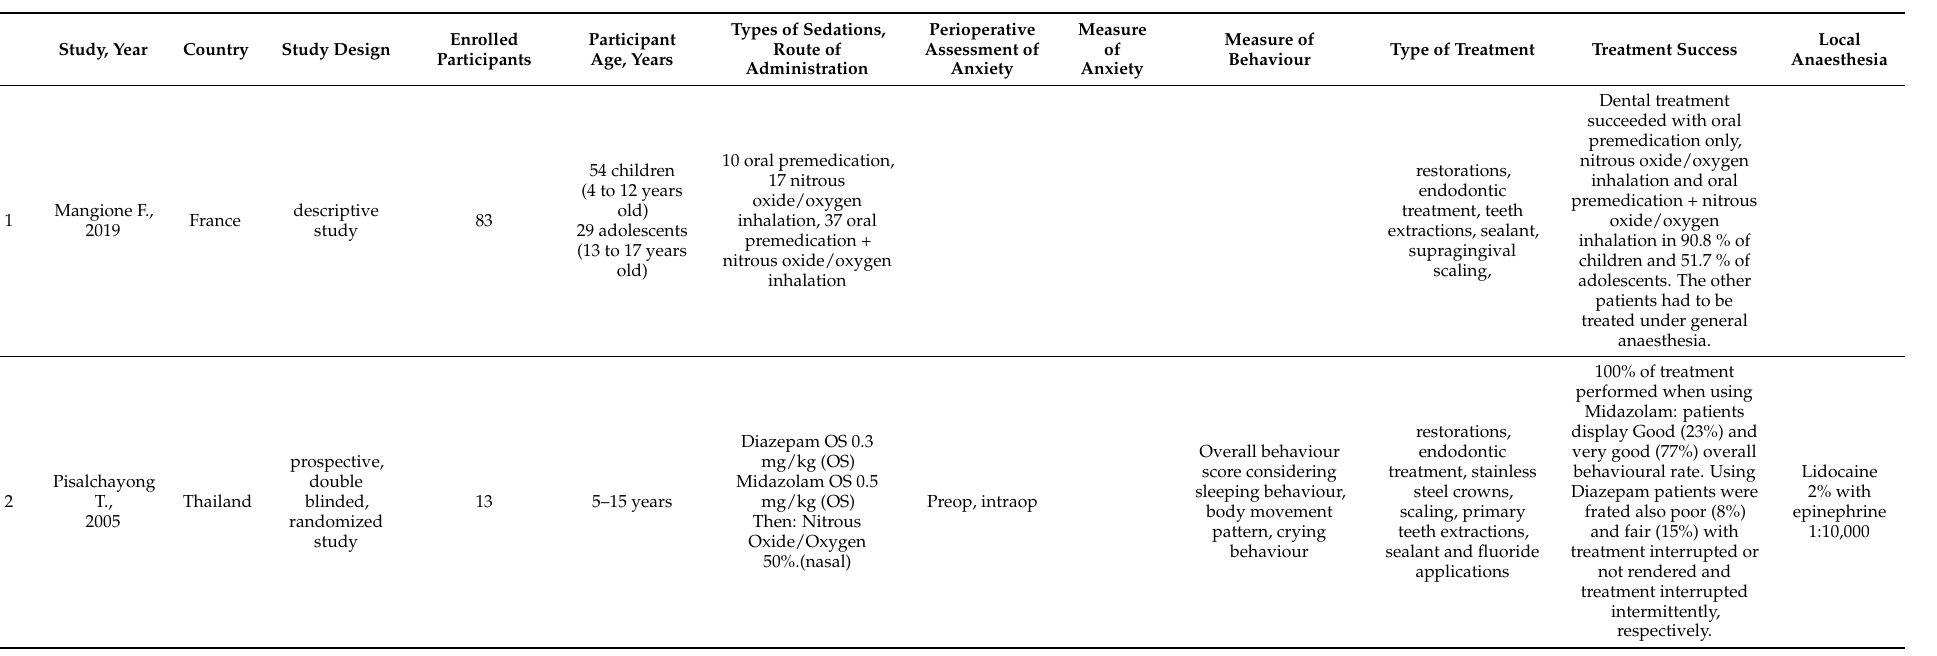
Table 2. Characteristics of the included